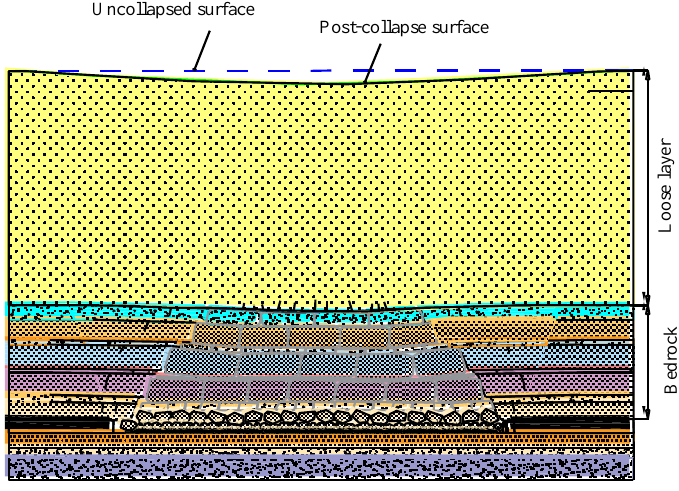
Figure 1. Schematic diagram of the subsidence of thick loose layer.